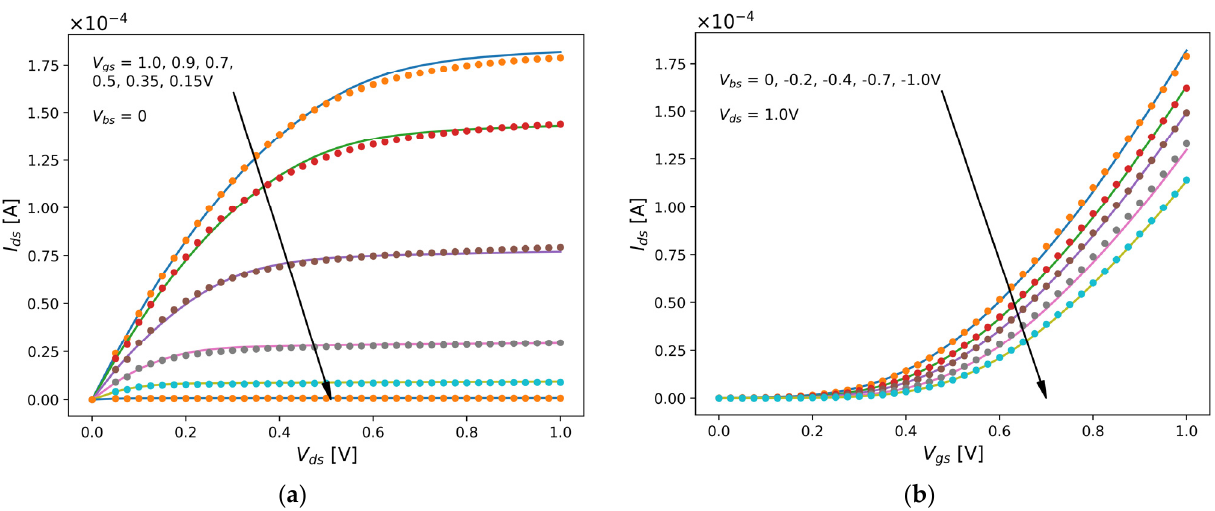
Figure 11. IV fitting curves for the second set of inputs: ( a ) I ds –V ds curves at different V gs when V bs =